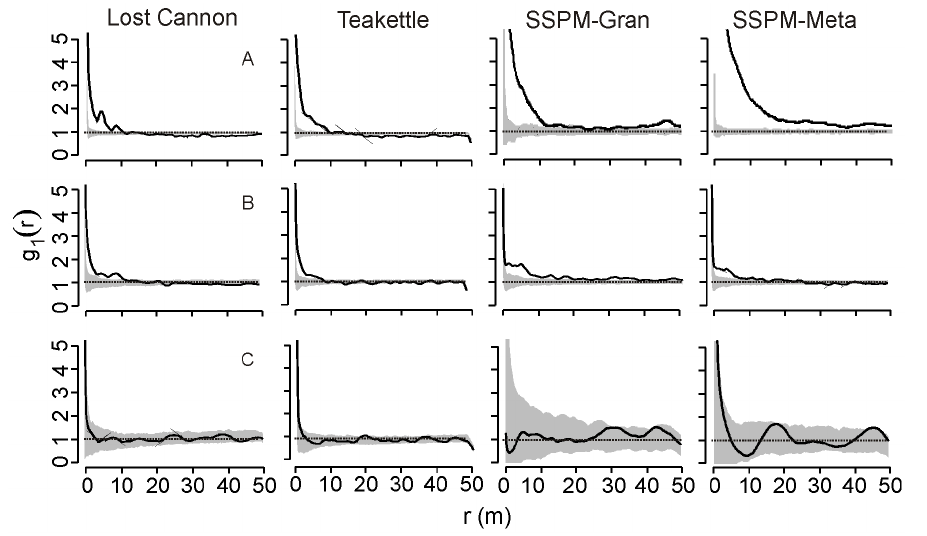
Figure 3. Comparison of the spatial pattern of live trees from four old-growth Jeffrey pine-mixed conifer forests (solid lines). The inhomogeneous pair correlation function with an Epanechnikov smoothing kernel was used for Lost Cannon and Teakettle. Analysis of tree size classes are arranged in rows: A, 5–25 cm DBH; B, 25–50 cm; C, 50–75 cm; and D, DBH . 75 cm. Approximately 95% simulation envelopes (grey shaded areas) were constructed with 199 Monte Carlo simulations of the CSR model.